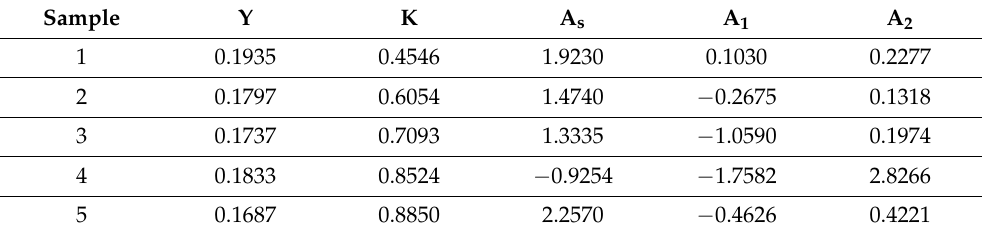
Table 9. Model parameters of sample points.